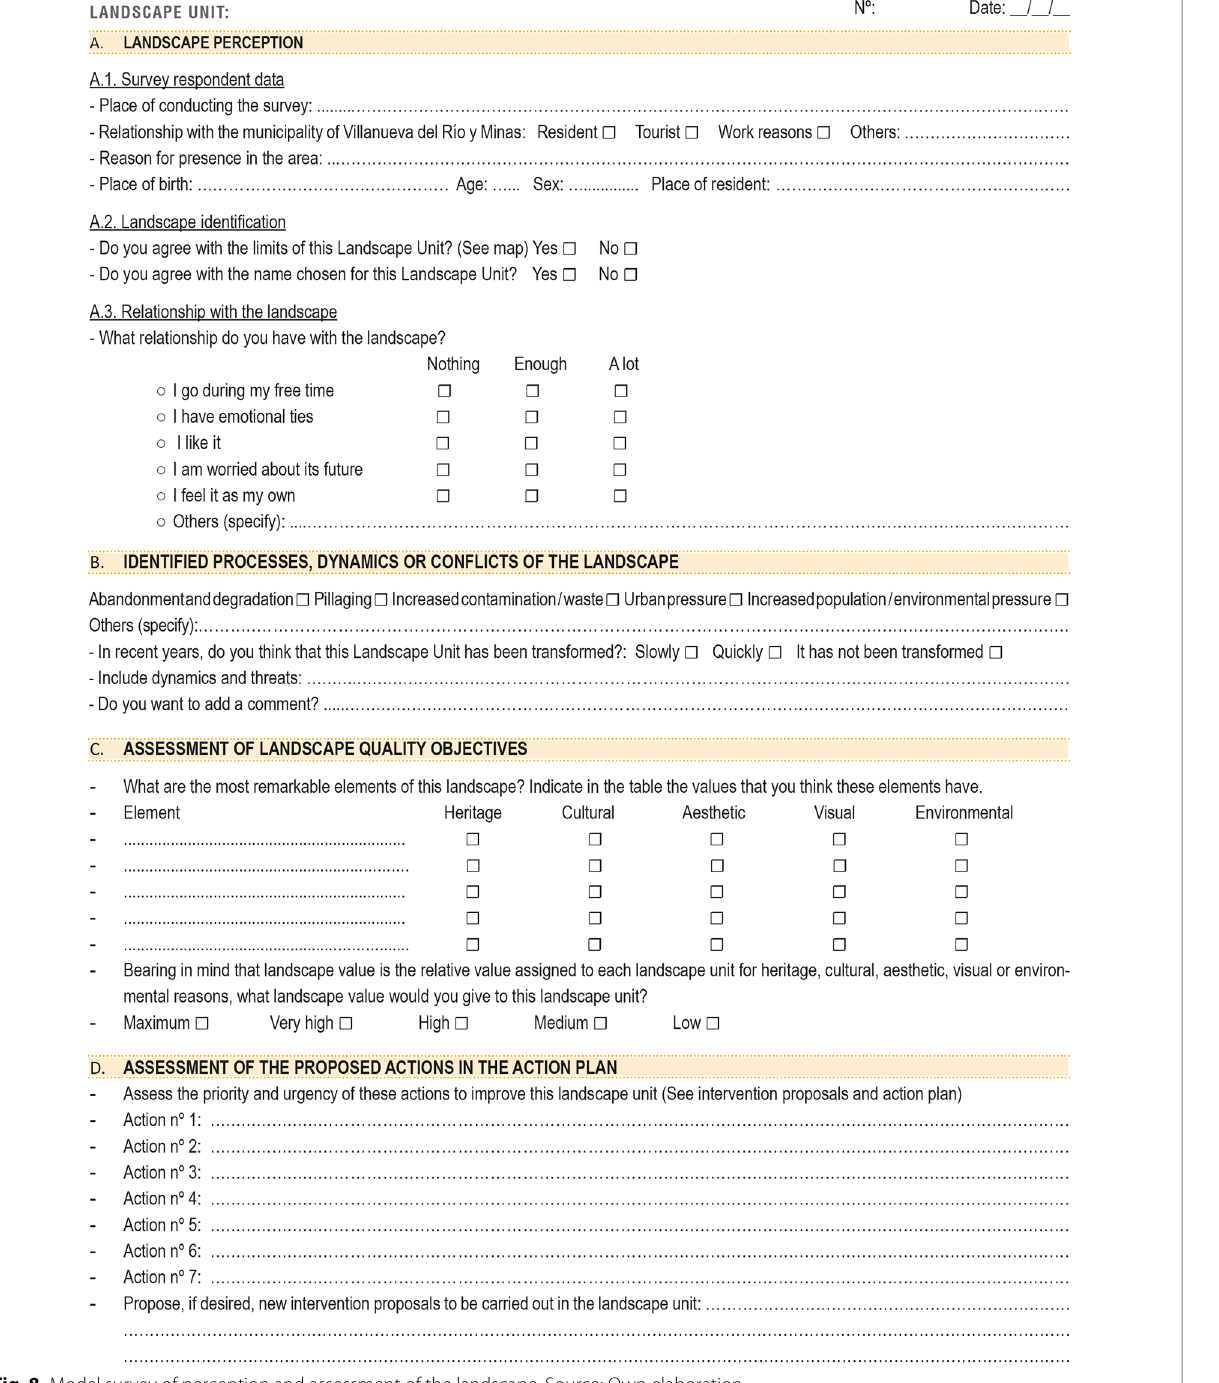
Fig. 8 Model survey of perception and assessment of the landscape. Source: Own